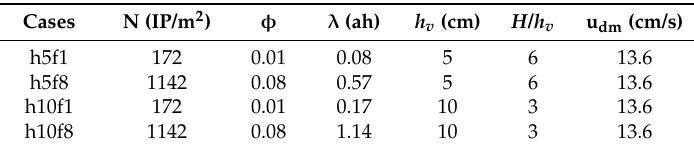
Table 1. Hydraulic